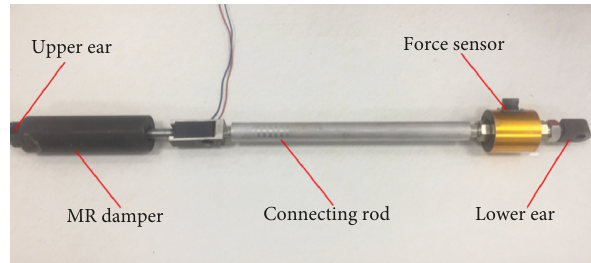
Figure 3: The MR damper prototype.